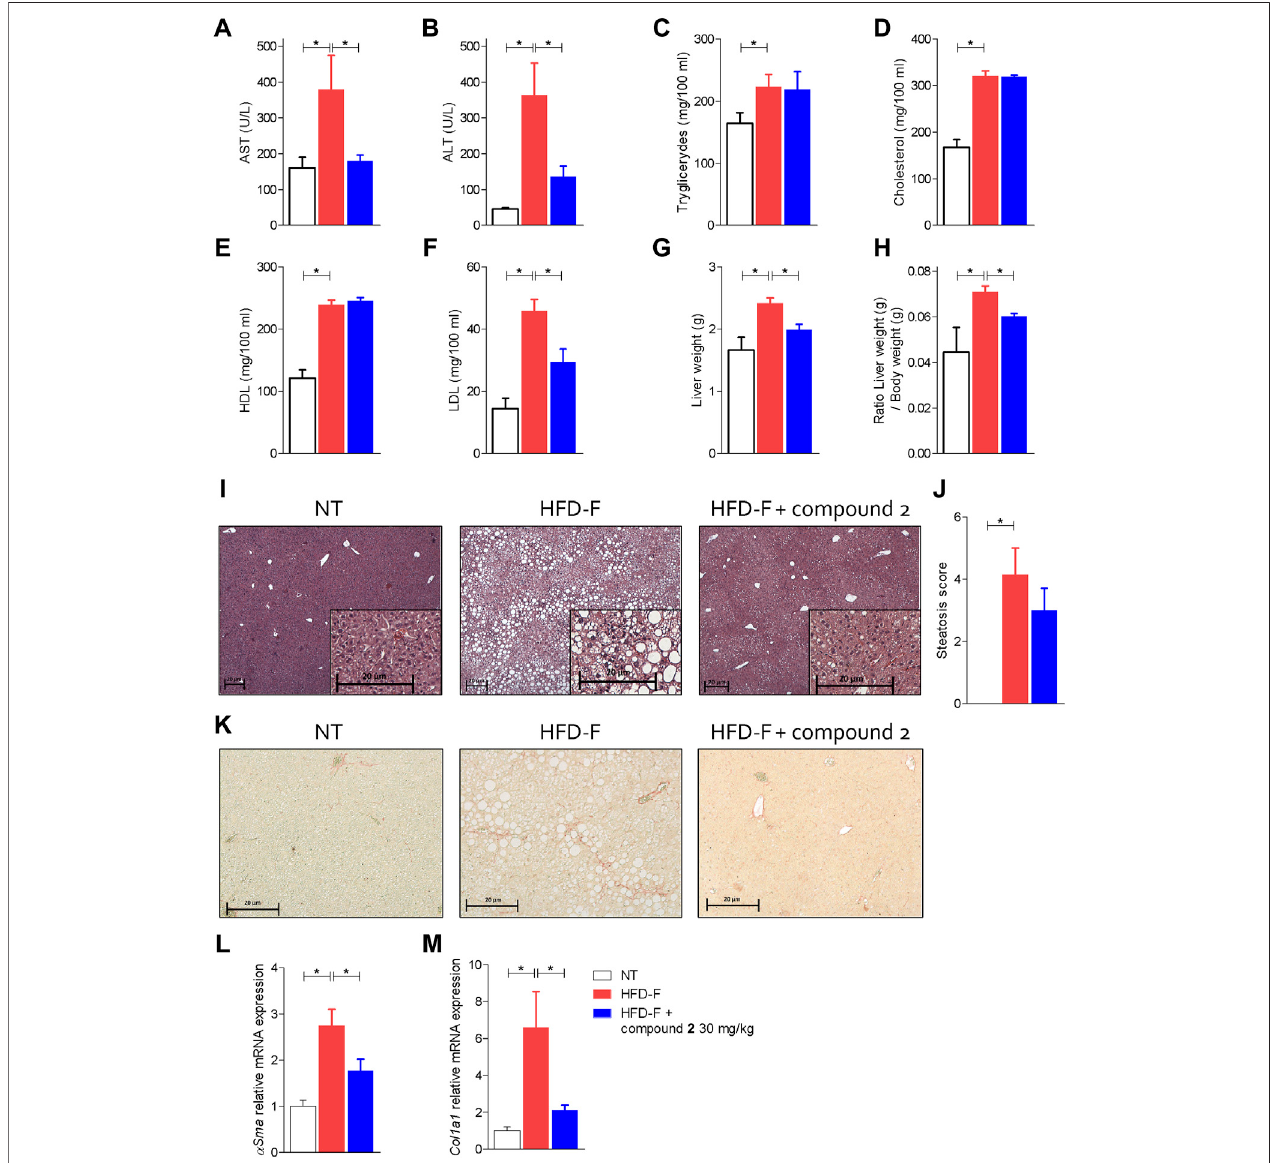
FIGURE6| Bene fi cial effects ofcompound 2on liverbiochemistry and histopathology. C57BL/6 male mice were fedahigh fatdiet and fructose(HFD-F)or normal chow diet for 61 days. From day 7, compound 2 was administered by oral gavage at the dose of 30 mg/kg/daily. Plasmatic levels of (A) AST, (B) ALT, (C) Triglycerides, (D) Cholesterol, (E) HDL,and (F) LDLattheendofthestudy.Macroscopic andmicroscopic features oftheliver: (G) liverweight(g), (H) ratiobetweenliverweight(g)and body weight (g), (I) hematoxylin and eosin (H&E) staining ofliver tissuesobtained at the end of the study (magni fi cation ×4, insets ×10) with (J) steatosis score, and (K) siriusredstainingoflivertissuesobtainedattheendofthestudy(magni fi cation×10).RelativemRNAexpressionlevelsof (L) α Smaand (M) Col1a1,measuredinliver. Results are the mean ± SEM of 5-7 mice per group; * p < 0.05.